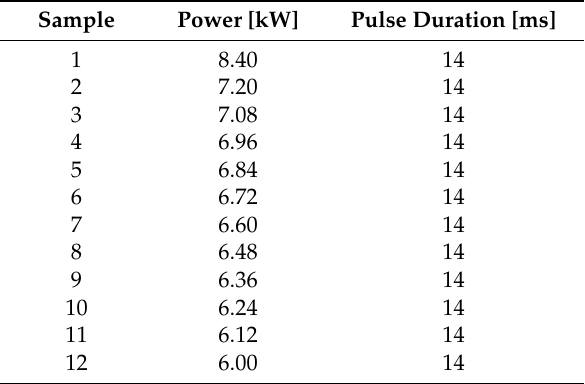
Table 4. Parametric study for steel–aluminum welding.